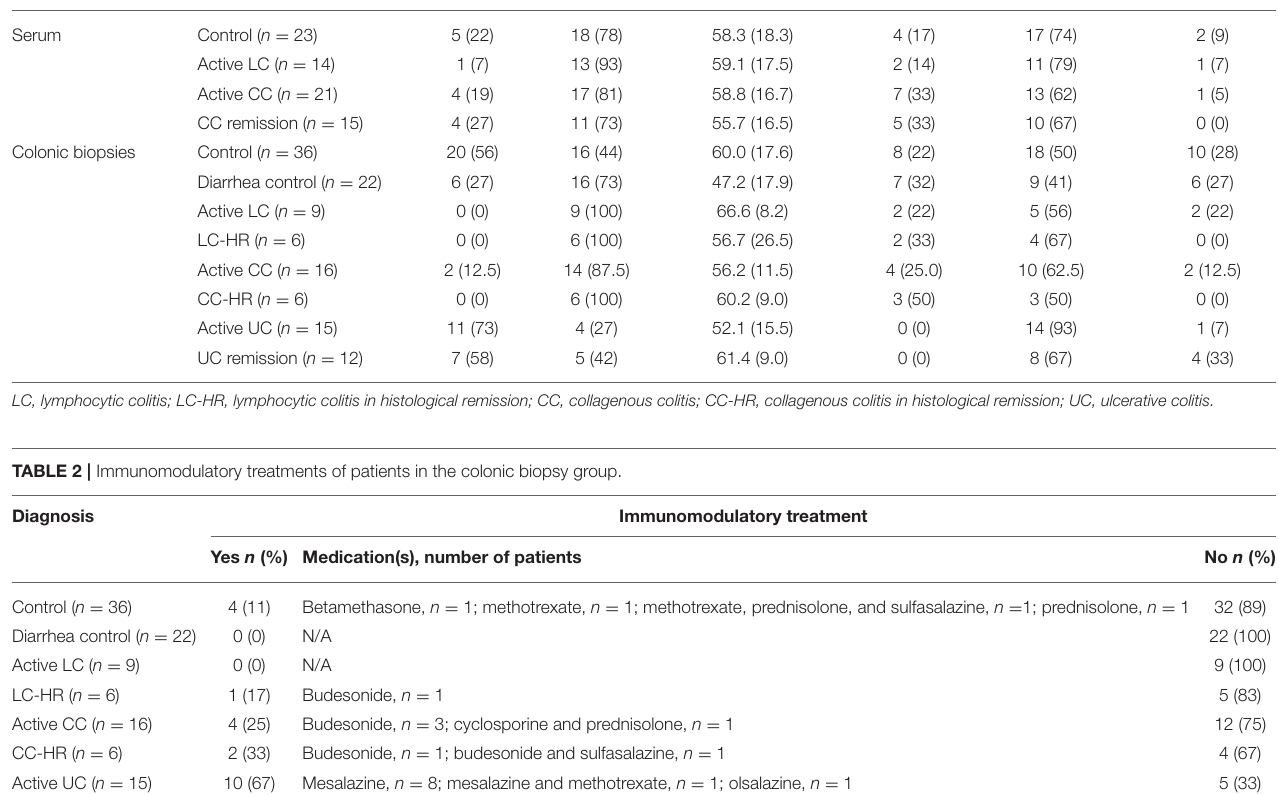
TABLE 1 | Patient demographics for serum and colonic biopsy samples. Sex: n (%) Smoking Diagnosis Male